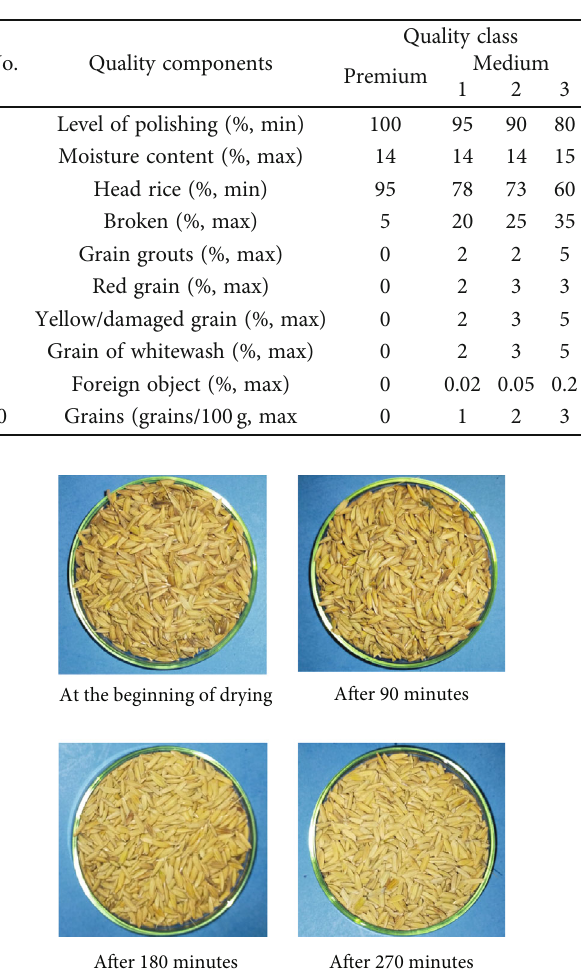
Figure 14: Variation of e ffi ciencies and improvement potential with drying time. Table 7: Performance evaluation of the PSBA-RMFD. Table 8: Indonesian national rice quality standard (SNI No.01- 6128-2015) [58].